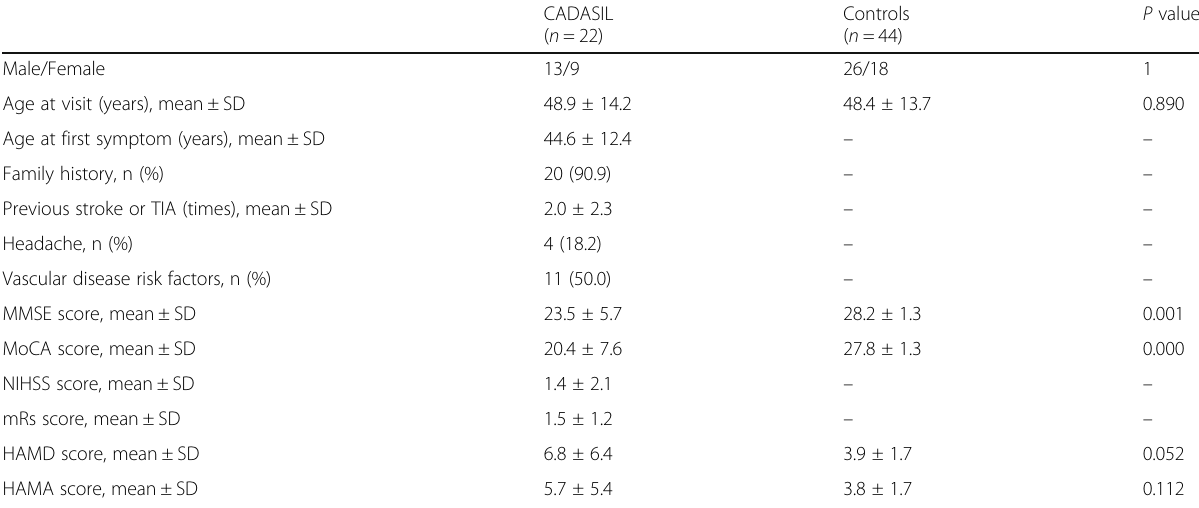
Table 1 Demographic and clinical characteristics of CADASIL patients and